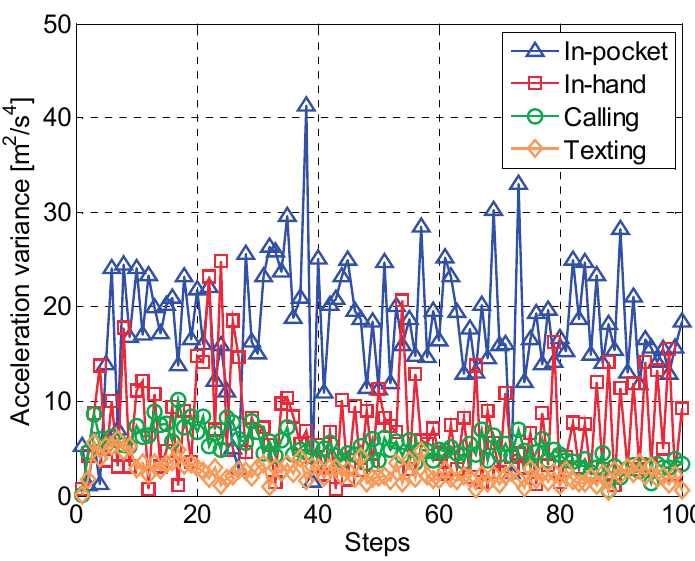
Figure 7. Acceleration variances in different contexts of carrying a